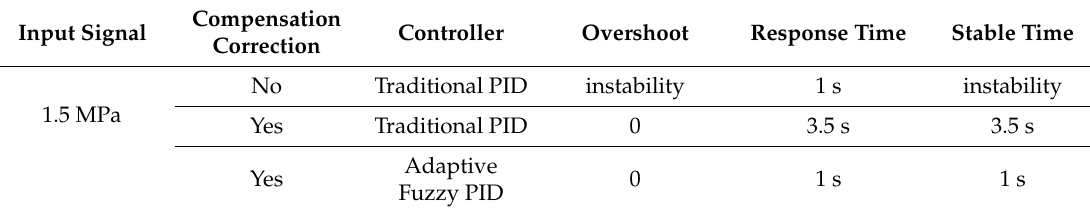
Table 3. Performance comparison of control algorithms.